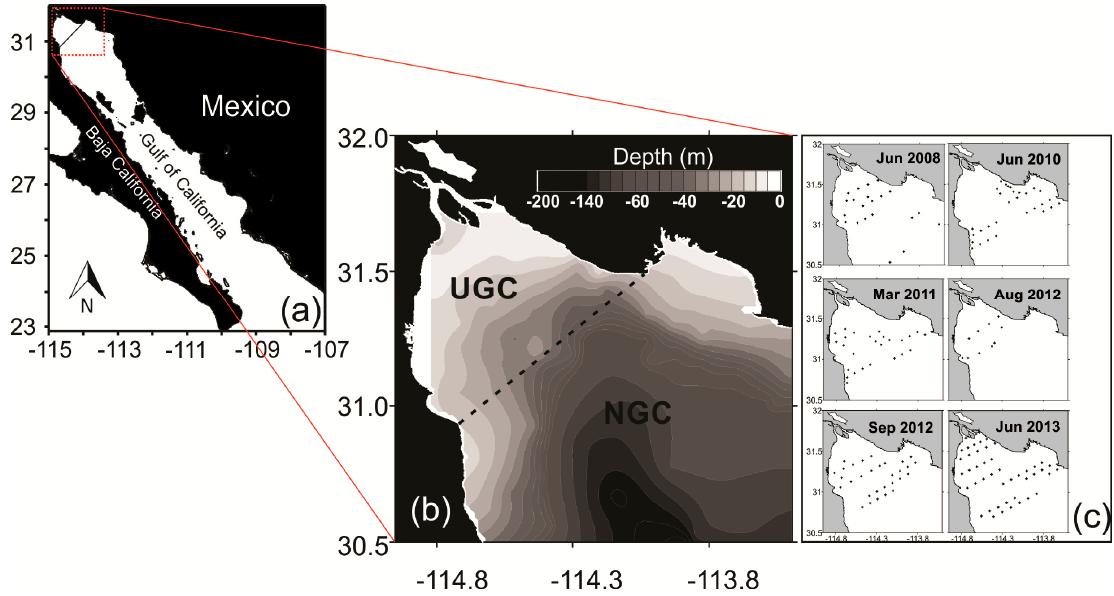
Figure 1. ( a ) Study area map. ( b ) Transition zone between the Upper Gulf of California (UGC) and Northern Gulf of California (NGC) bio-optical regions, indicated by the dotted line. ( c ) Station location for each cruise.